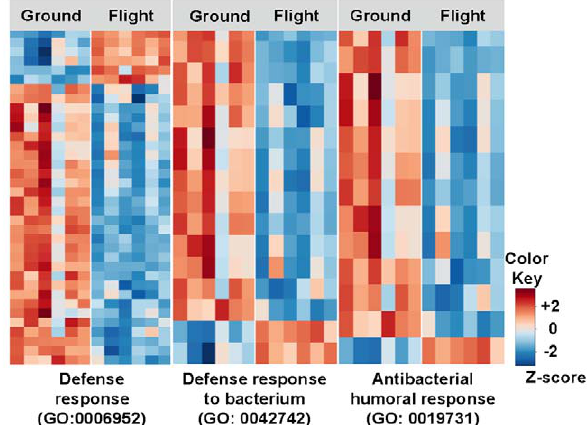
Figure 3. Humoral responses are downregulated in spaceflight larvae. Gene Ontology (GO) categories of defense response show altered gene expression in flight larvae compared to ground-reared larvae: 30 out of the 37 classified as defense response are downregulated in flight. These include the majority of response to bacteria and in particular humoral response genes. Six experimental repeats of each of the samples (flight and ground) were used to extract RNA for microarray analysis and are represented in individual columns in the figure. Rows represent levels of individual gene expression in each of the experimental repeats. Data is shown following Z-score transformation. Red colors indicate Z-scores . 0 (above mean), blue colors indicate Z-scores , 0 (below mean). The gene names can be found in Tables 1 and 2.